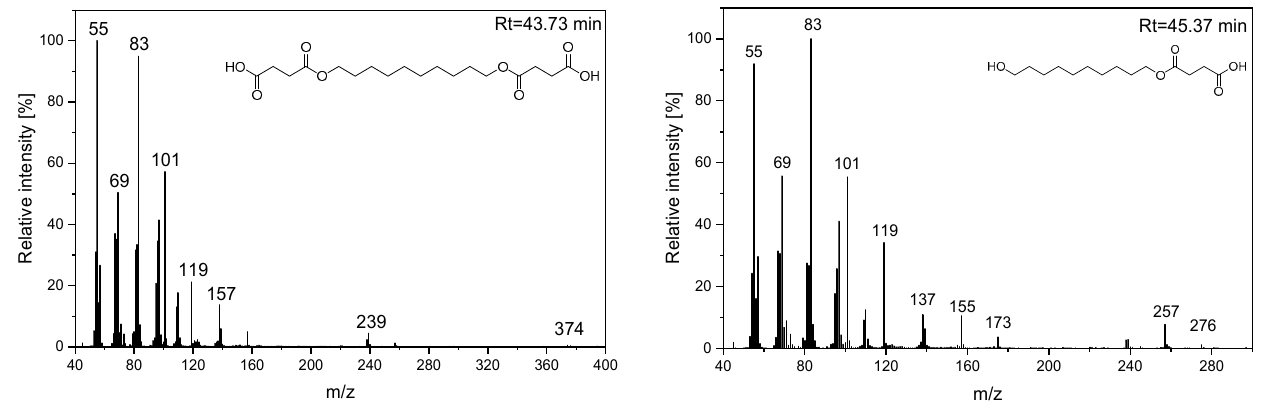
Figure 7. Mass spectra of the major decomposition products of PDeSu.